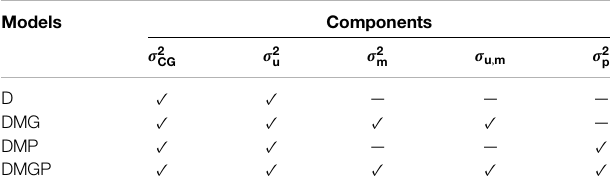
TABLE 2 | Random effects included in the four animal models for yearling temperament in American Angus cattle.